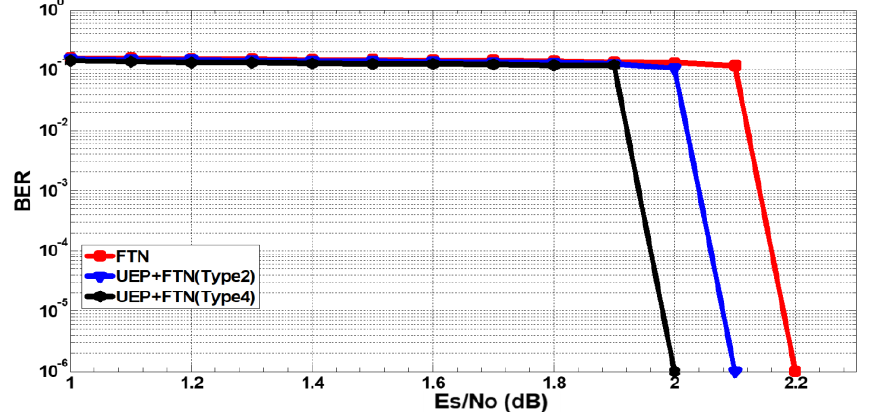
Figure 9. The performance of the FTN method based on the UEP algorithm ( τ (cid:48) = 30%).